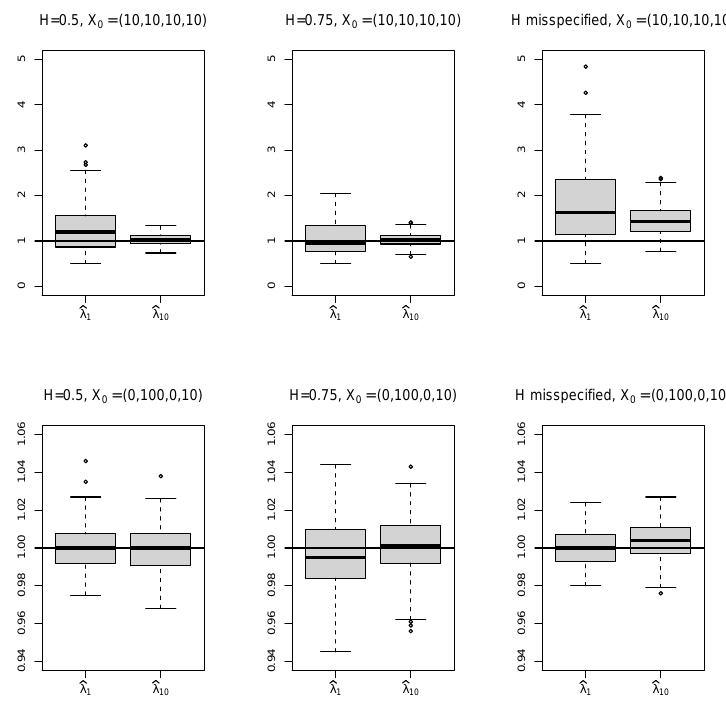
Figure 6. Boxplots of the estimated λ in Example 2 for time horizons T = 1 (denoted by (cid:98) λ 1 ) and T = 10 (denoted by (cid:98) λ 10 ) calculated for 100 samples in every case considered; the horizontal line shows the true value of the estimated parameter λ =